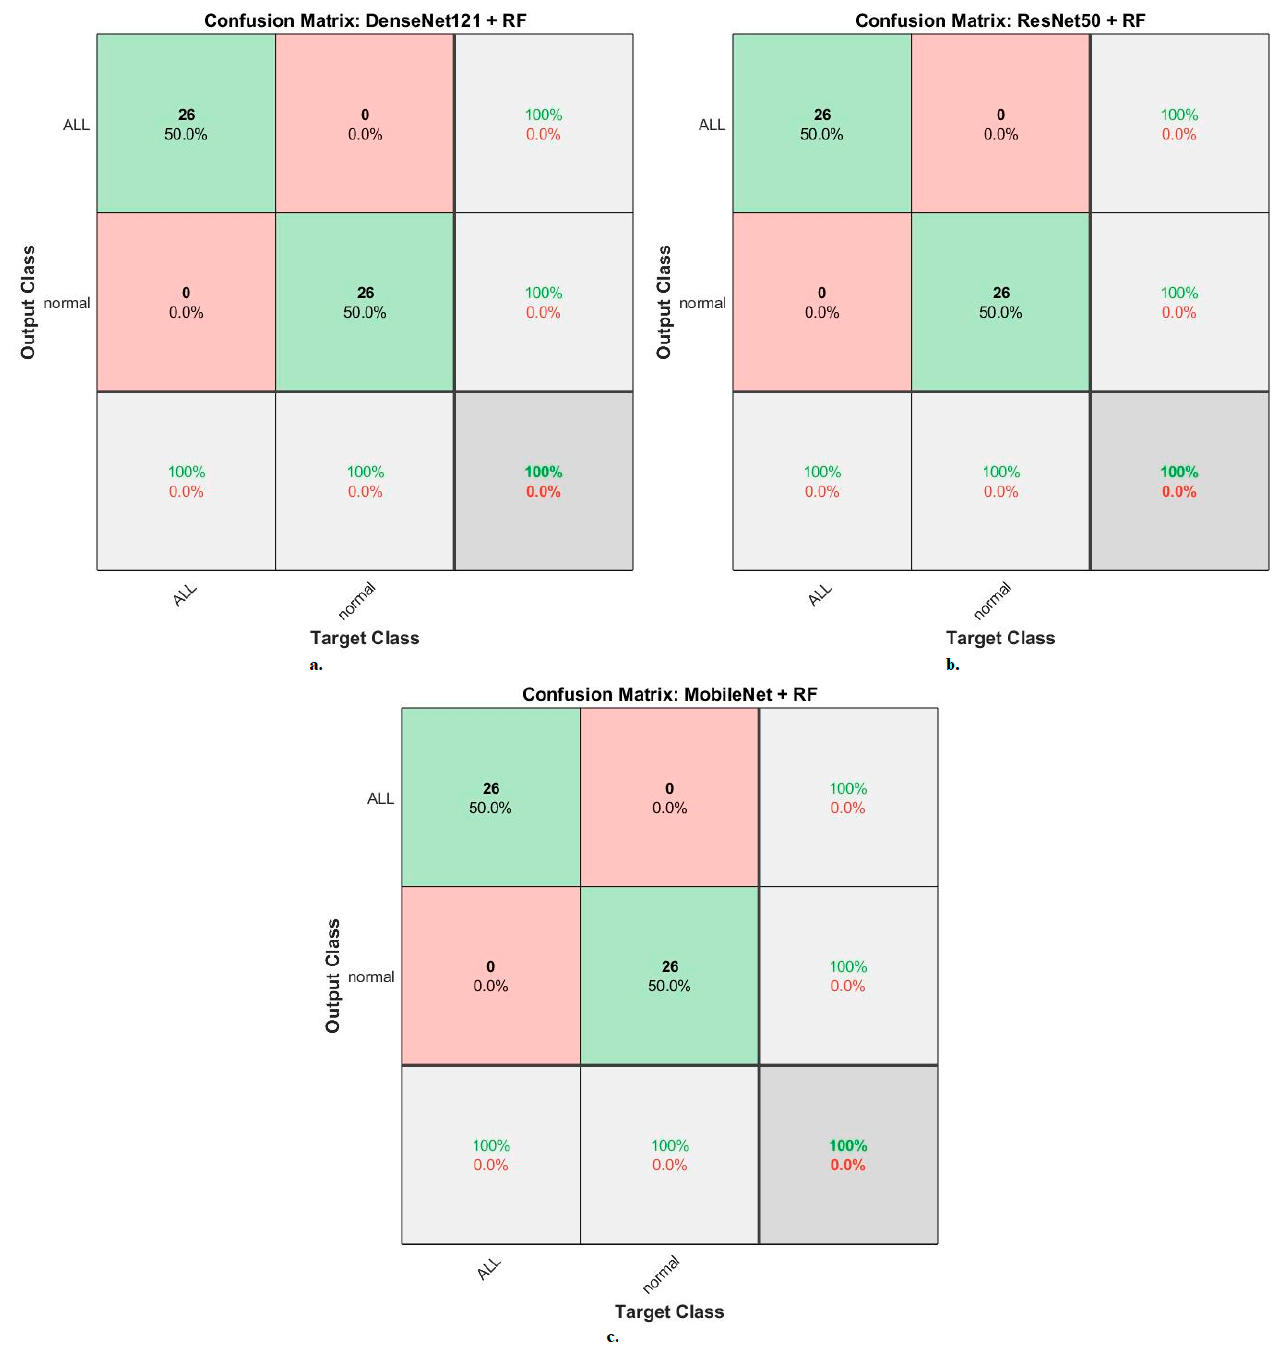
Figure 12. Results of the RF classifier based on the features of the CNN models of the ALL-IDB2 dataset for the diagnosis of acute leukemia confusion matrix of ( a ) DenseNet121-RF. ( b ) ResNet50-RF. ( c ) MobileNet-RF.